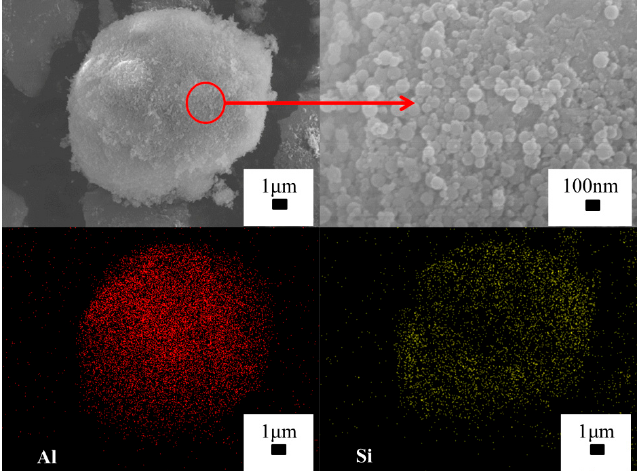
Figure 2. SEM and EDS images of SiO 2 @Al.